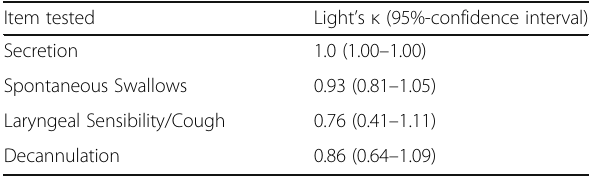
Table 2 Test-retest reliability in a group of ‘ experts